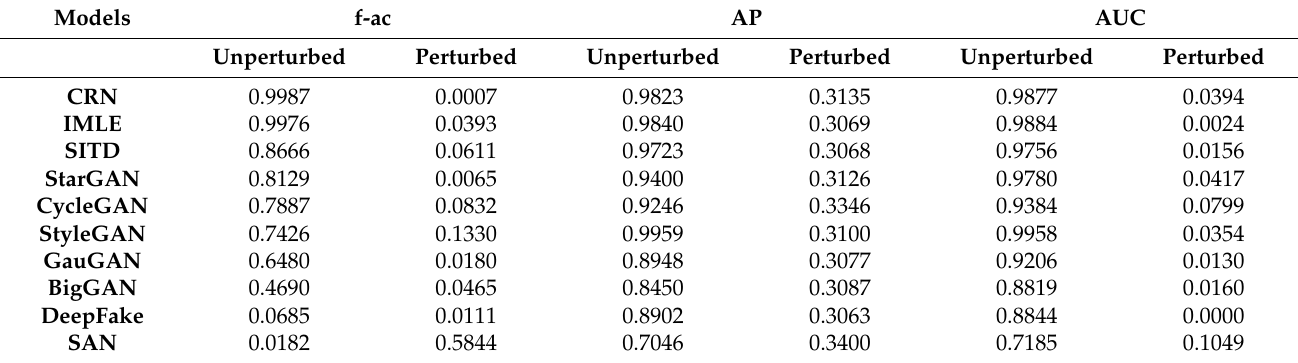
Table 3. Generalization comparison of the detector before and after adding perturbation by